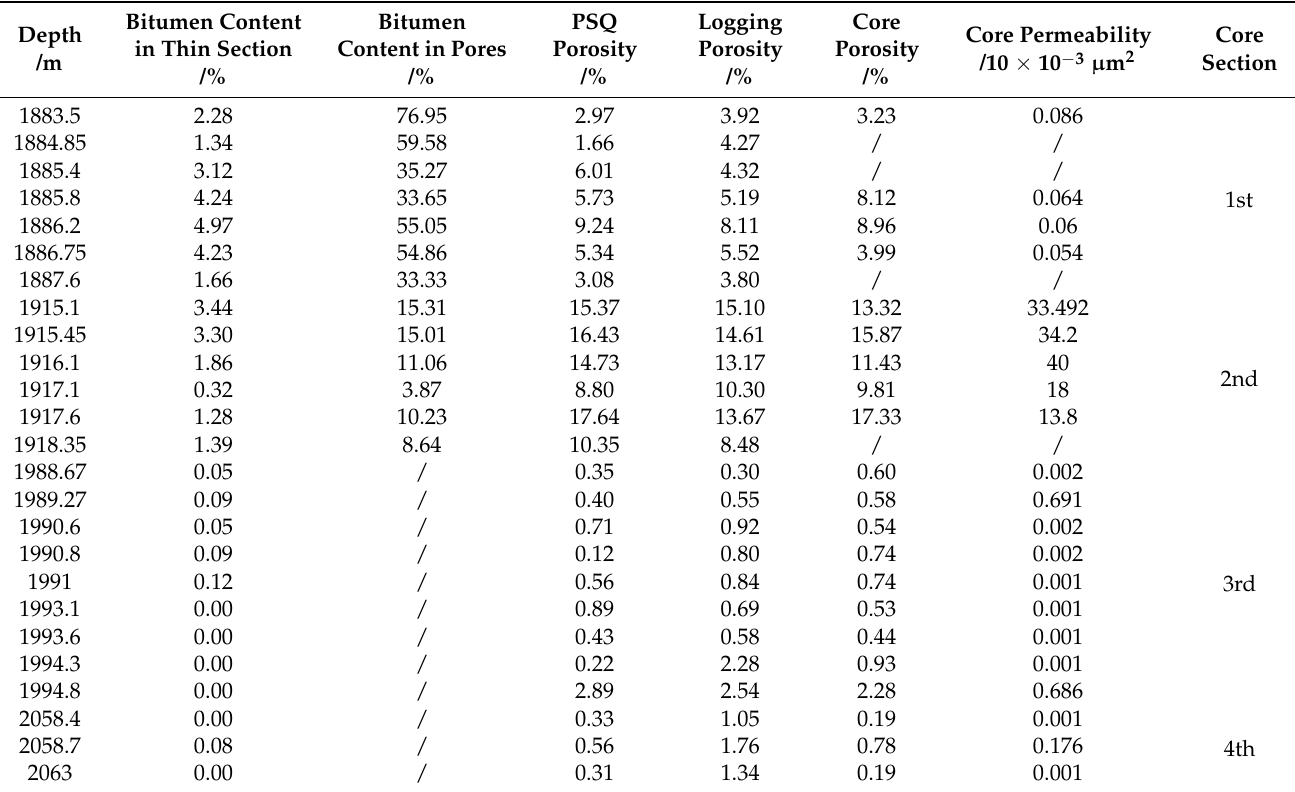
Table 1. Bitumen content, porosity and permeability of core sections in Well Shutan 1.